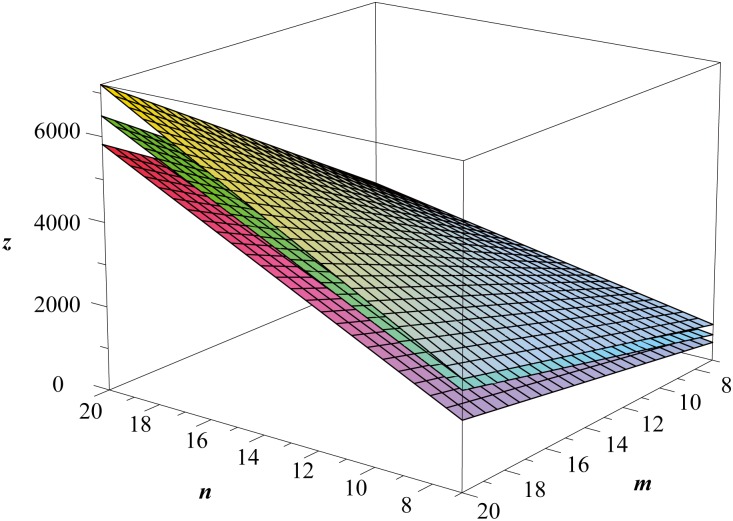
The Wiener polarity index of Tt(n, m), Tc(n, m) and Tf(n, m).